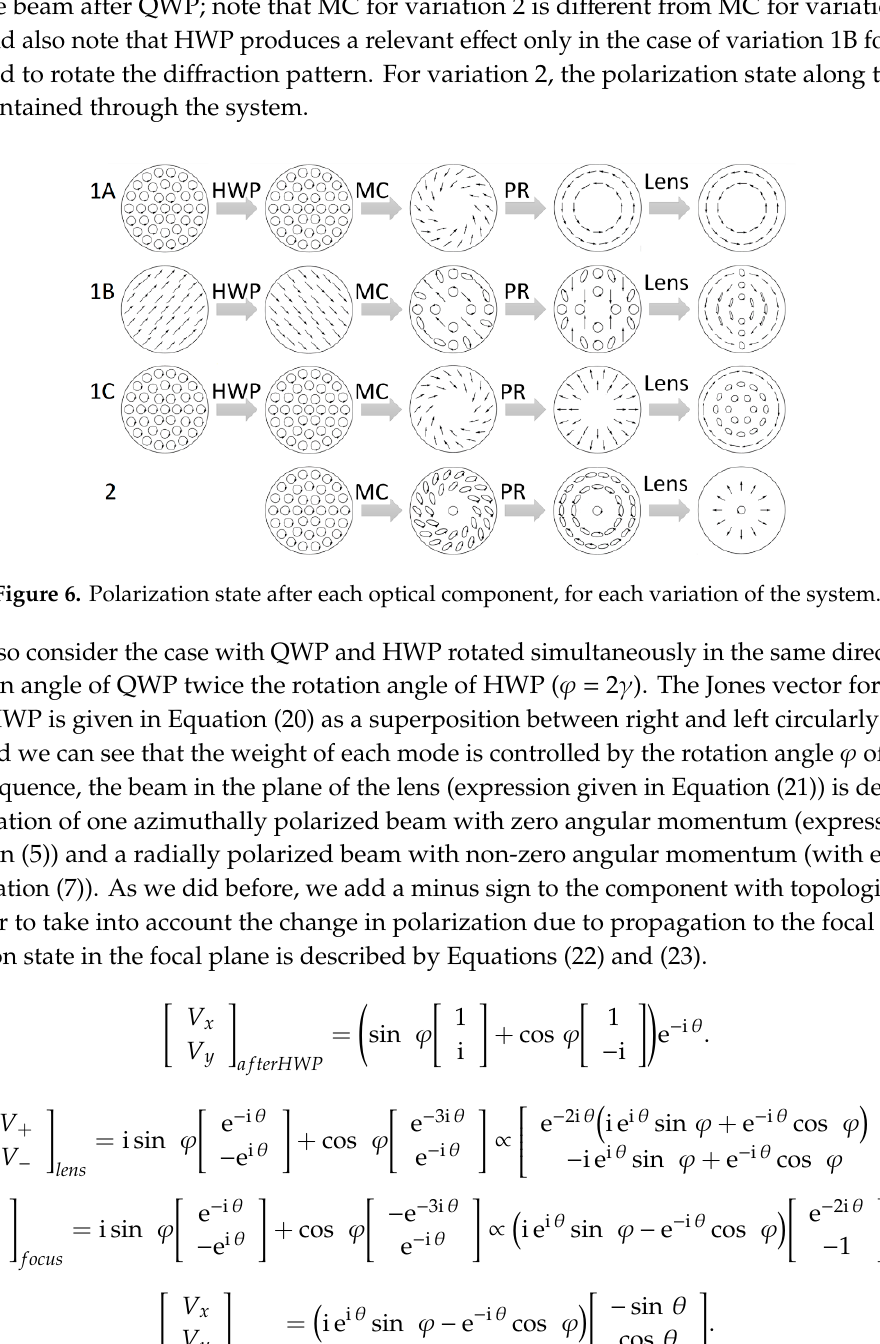
axis is maintained through the system.